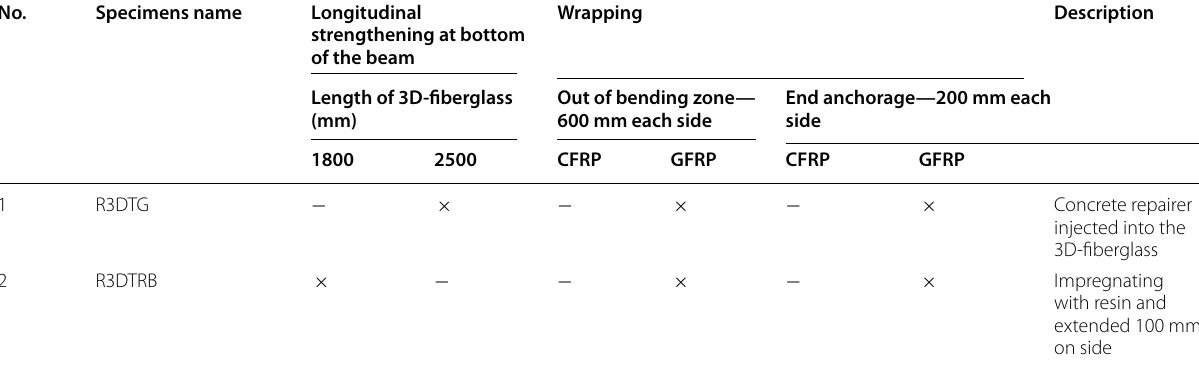
Table 8 Nomenclature of the two additional tested beams: R3DTG and R3DTRB.